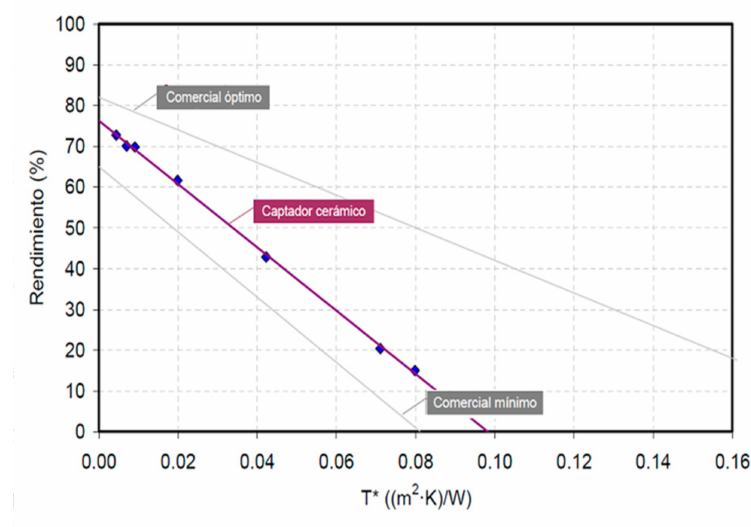
Figure 4. Characteristic curve that defines the performance of the ceramic solar collector.